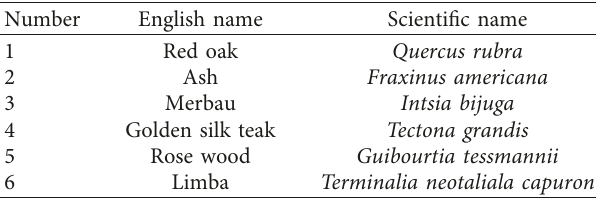
Table 1: Species